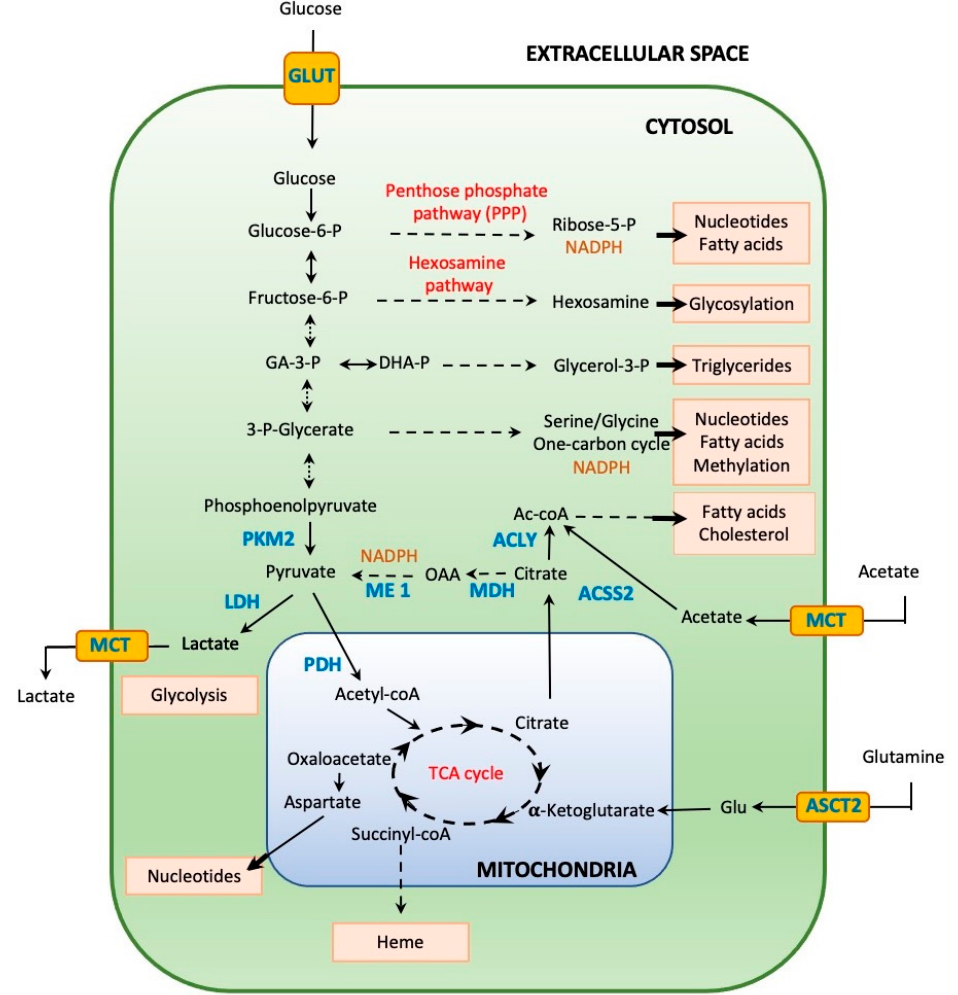
Figure 4. Major elements of cancer cell metabolism rewiring. Cancer cells rewire their metabolic